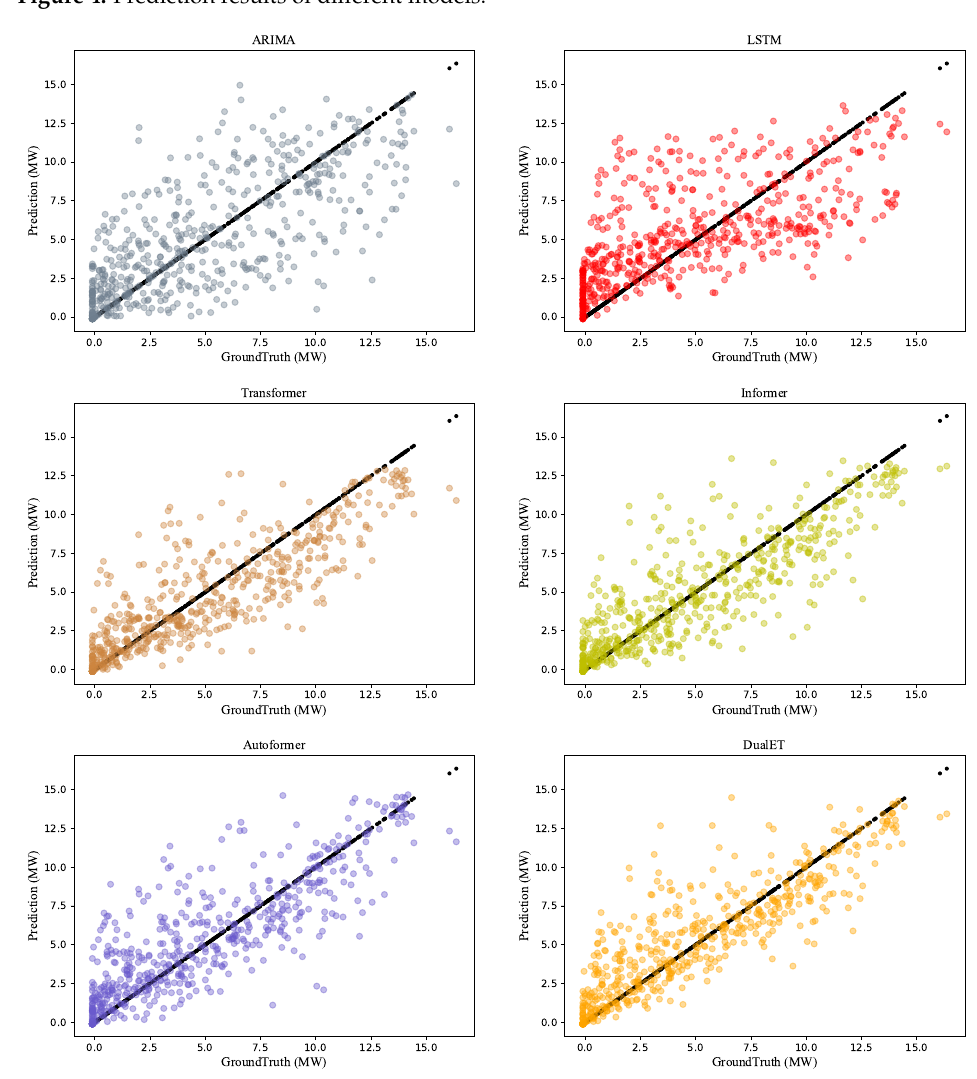
Figure 5. Scatter plots of different